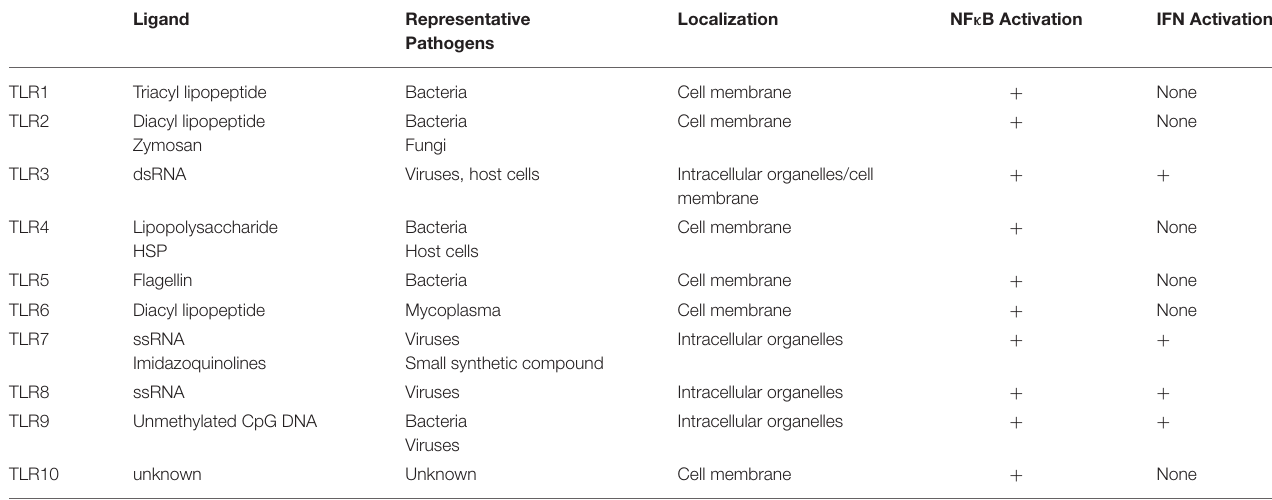
TABLE 1 | Characteristics of